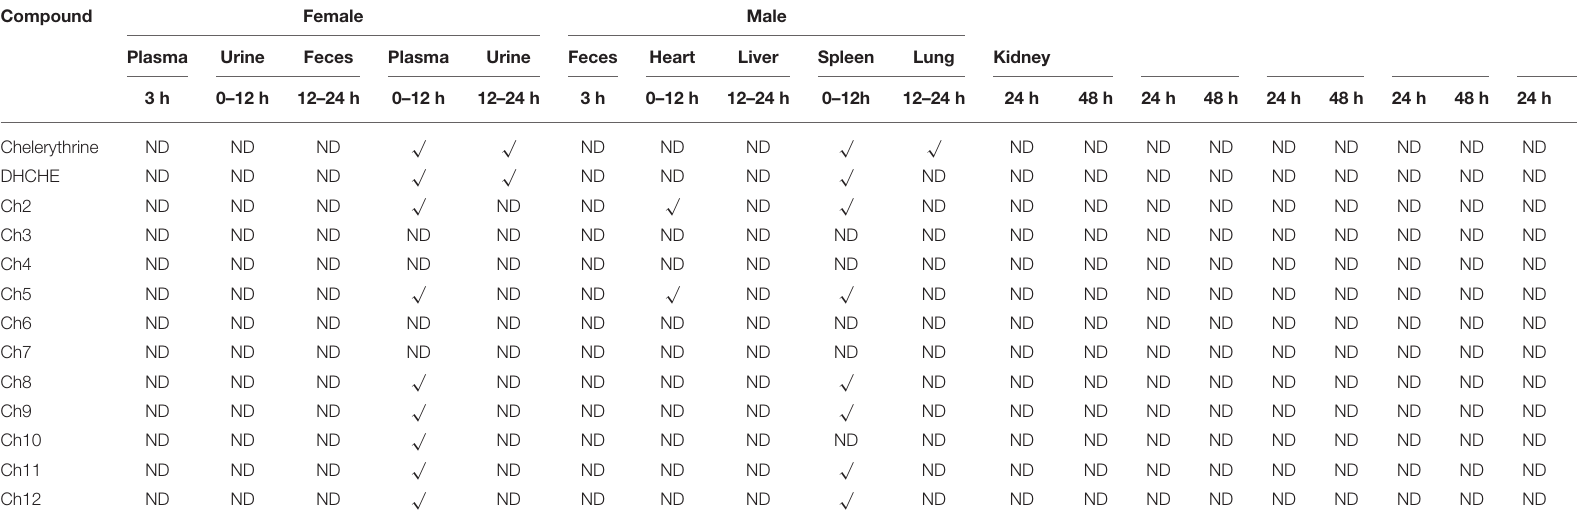
TABLE 2 | Summary of chelerythrine metabolites detected in the plasma, urine, feces, and tissues of rats. Compound